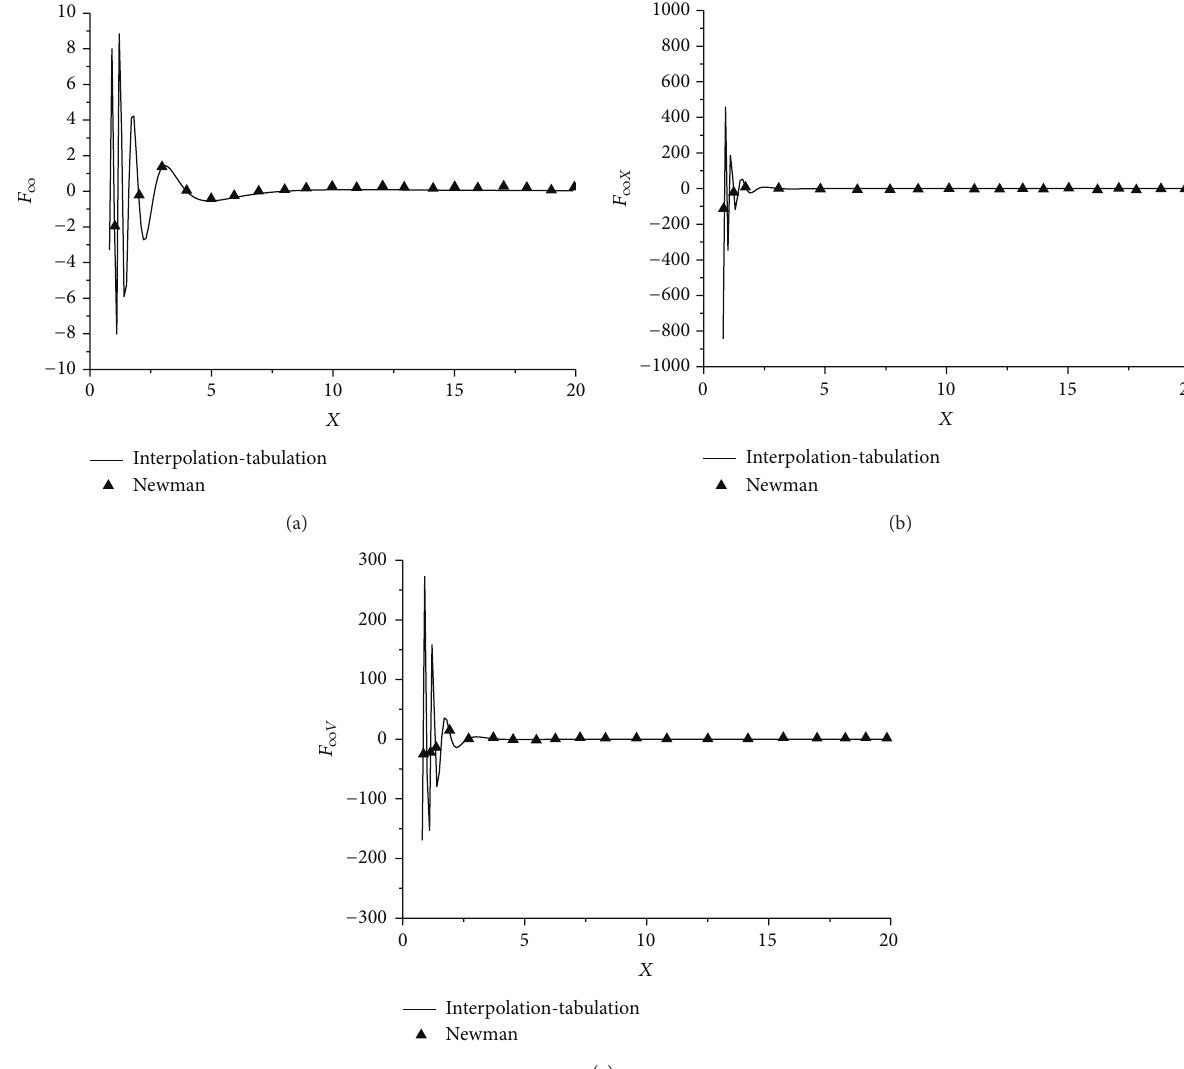
Figure 5: Comparison of 𝐹 ∞ , 𝐹 ∞𝑋 , and 𝐹 ∞𝑉 by the interpolation-tabulation method with Newman.